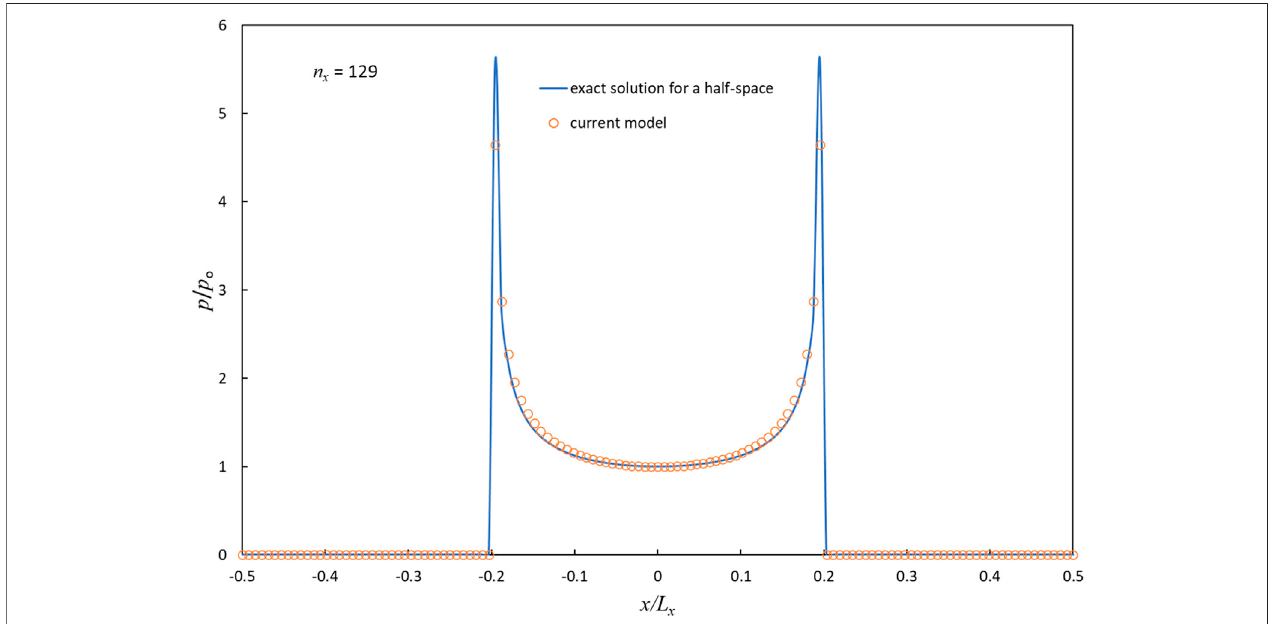
(cid:26)(cid:26)(cid:26)(cid:26)(cid:26)(cid:26)(cid:26)(cid:26)(cid:26) (cid:31) 1 − ( x / a ) 2